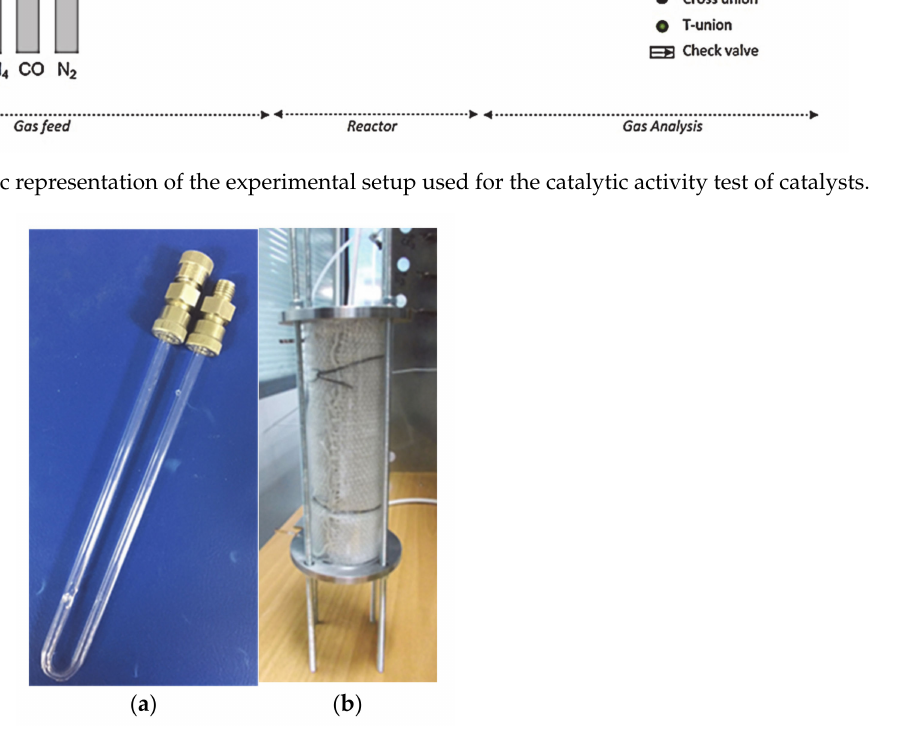
Figure 7. ( a ) U-shaped quartz reactor for activity testing of catalyst powders; ( b ) tube experimental electrical